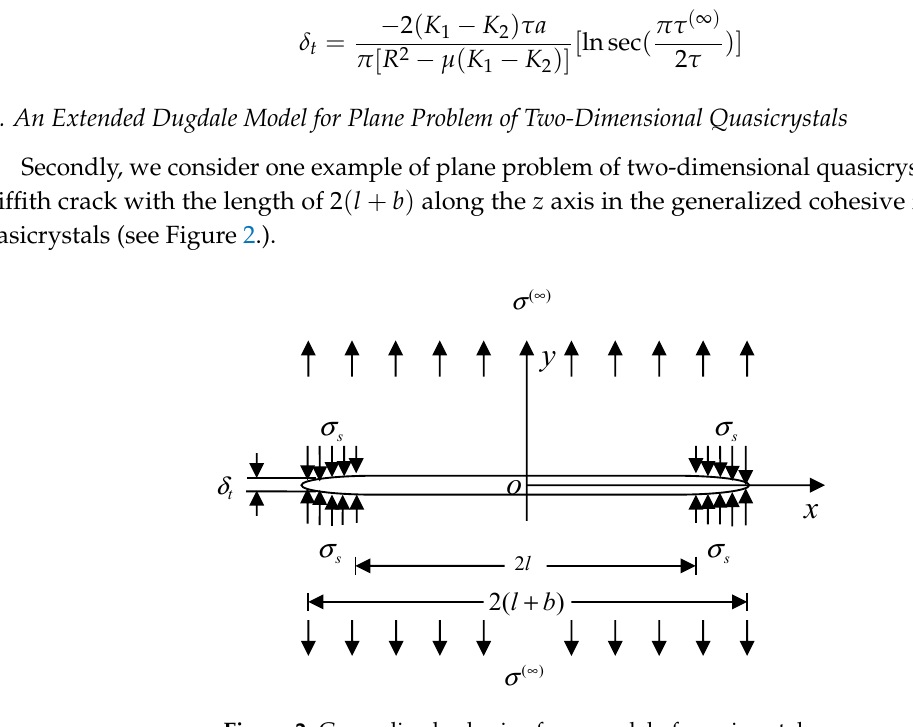
Figure 2. Generalized cohesive force model of quasicrystals.